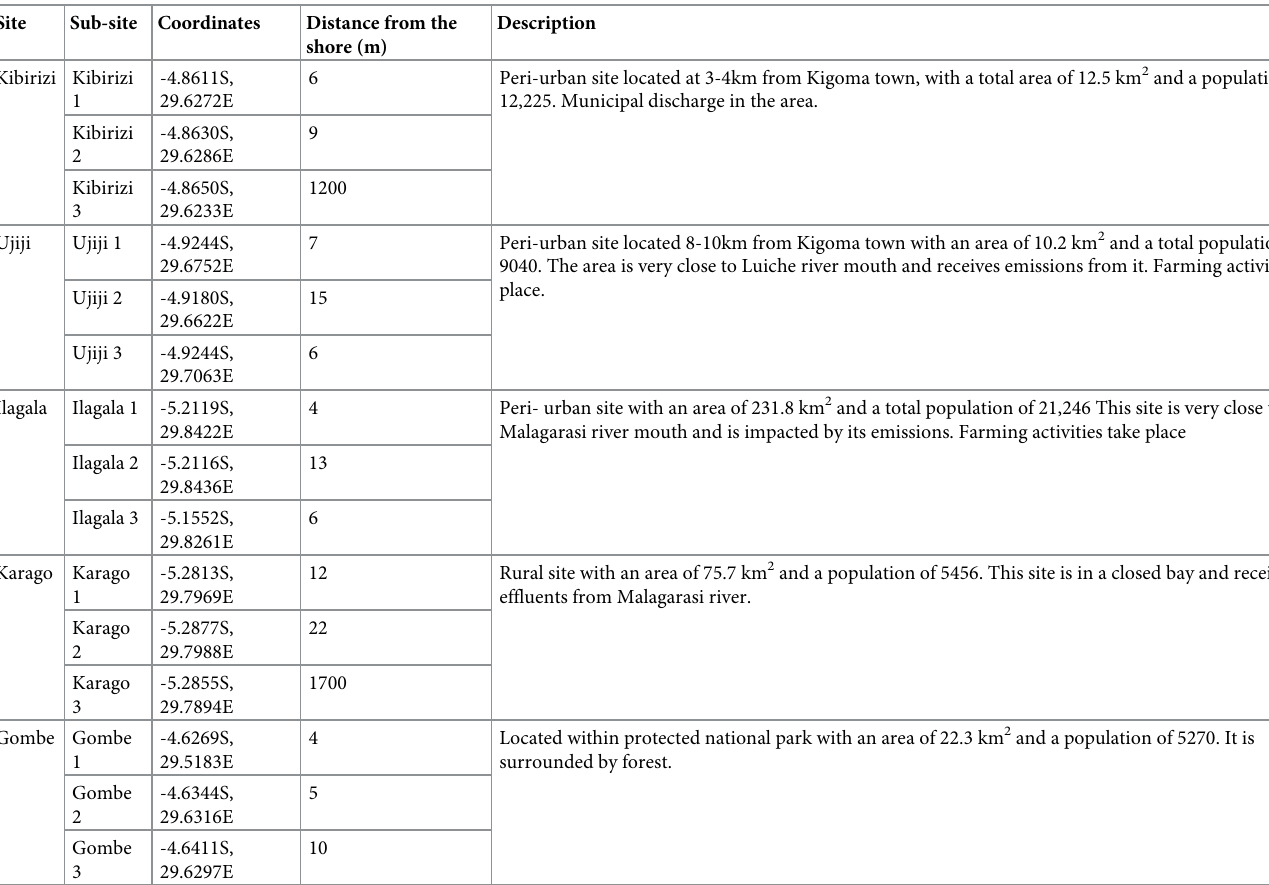
Table 1. Location and description of study sites and associated